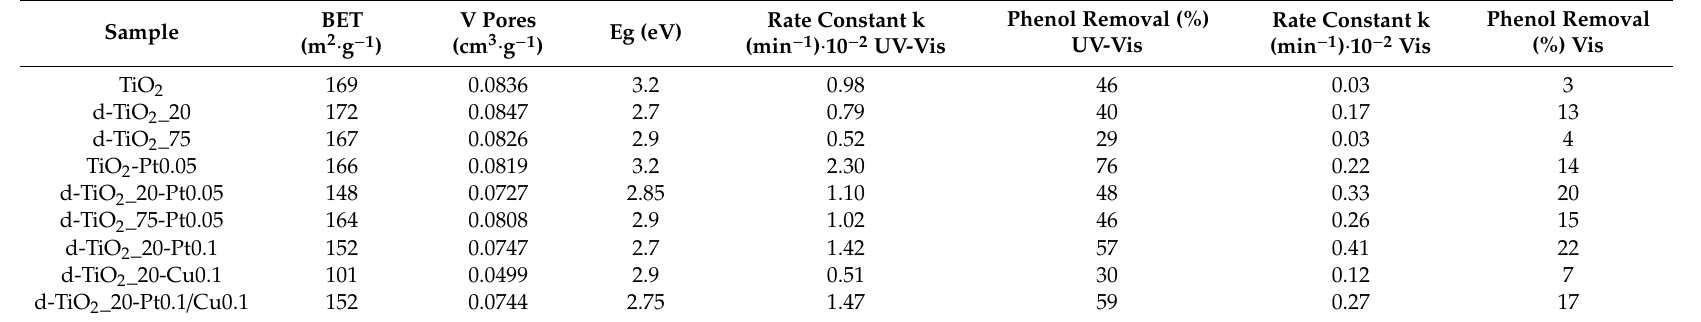
Table 1. Physicochemical and photocatalytic characteristics of the obtained defective d-TiO 2 -Pt / Cu samples.